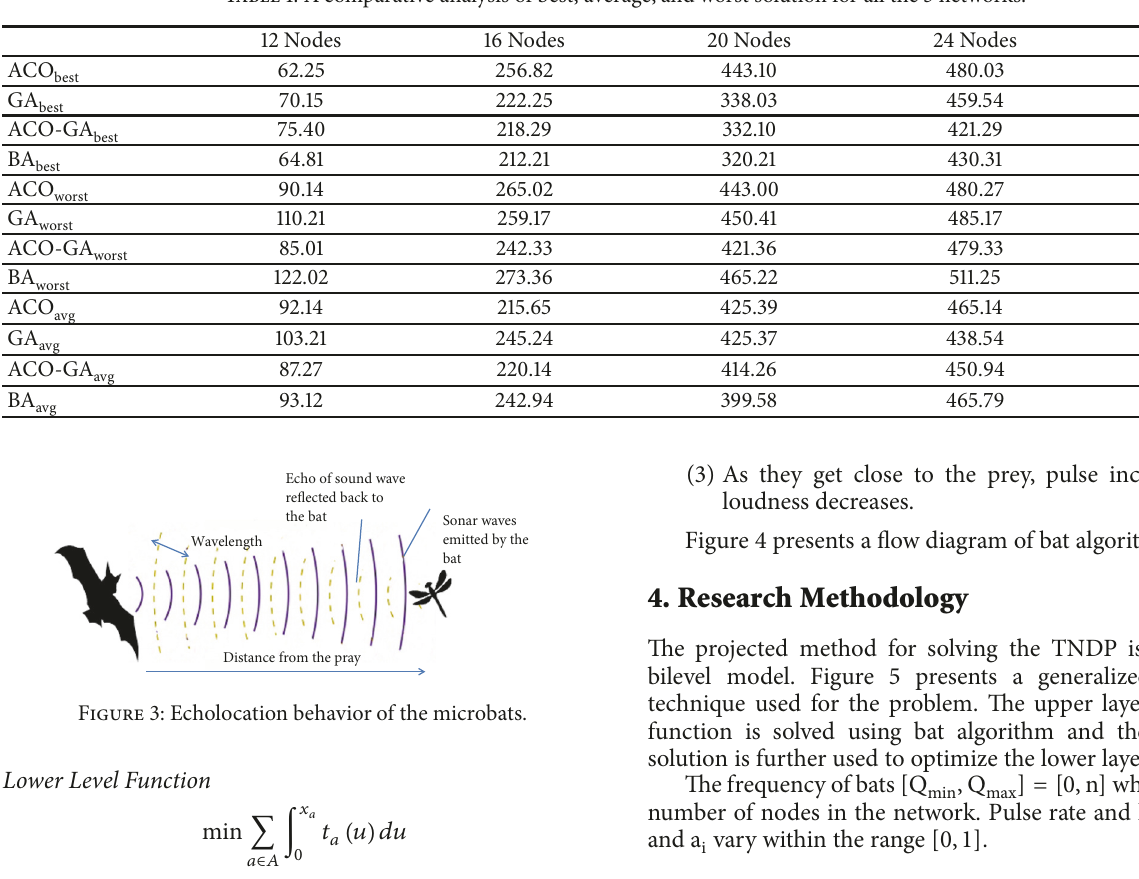
Table 1: A comparative analysis of best, average, and worst solution for all the 5 networks.